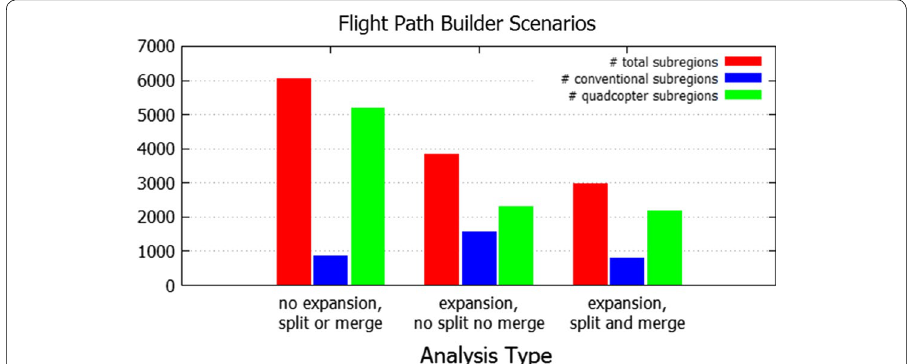
Fig. 12 All the subregions for both conventional drones and quadcopters broken down by analysis